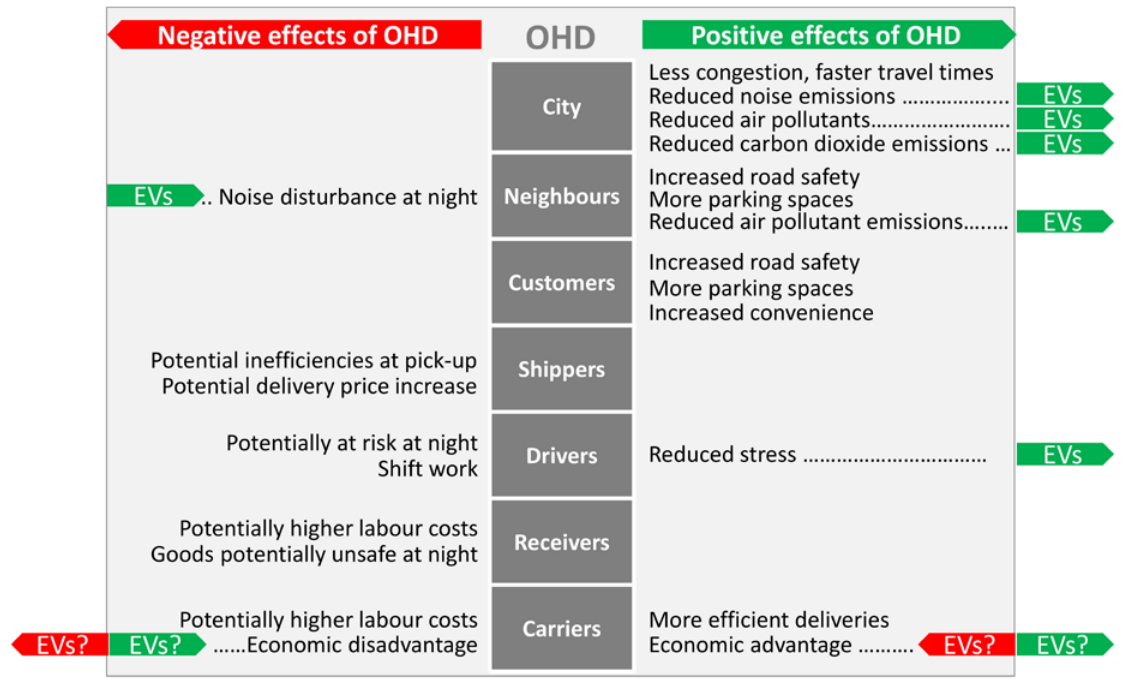
Figure 1. The impact of electric vehicles on stakeholder effects of off-hour delivery schemes City dwellers benefit more from a fluid traffic and thus from overall and lower noise, CO 2 and air pollutant emissions (Balm et al., 2014; Cavar et al., 2011; Geroliminis and Daganzo, 2005; Roumboutsos et al., 2014; Silas et al., 2012). The objection of neighbours to potentially higher noise emissions at night is problematic (Balm et al., 2014; Cavar et al., 2011; Russo and Comi, 2010; Suksri et al., 2012). Noise might be reduced by implementing a certified silent delivery chain (Dizian, 2012) which includes more silent EVs (Lu¨tzenberger et al., 2015; Wang et al., 2013). Neighbours and customers benefit from enhanced road safety; since traffic of heavy delivery vehicles and second- row parking is reduced, passengers can cross the streets more safely (Cavar et al., 2011; Silas et al., 2012). Additionally, the shopping convenience for customers can increase, since the shop staff have more time for the customer requests in daytime, and goods are not stored in the aisles and refilled during the daytime (Cavar et al., 2011; Silas et al., 2012). For shippers the time of the delivery has no impact, as long as the product reaches its destination on time, unless they experience delivery price increases and inefficiencies during the pick-up process leading to higher costs (Holgu´ın-Veras et al., 2005). Drivers, on the one hand, feel less stressed due to the predictable times of arrival, closer parking to the receiver, reduced probability of fines, and generally lower traffic level in New York City (Holgu´ın-Veras et al., 2013). On the other hand, their safety, as well as the safety of the goods, is problematic in some delivery areas (Balm et al., 2014; Cavar et al., 2011; Holgu´ın-Veras et al., 2005). Furthermore, the negative effects of shift-work